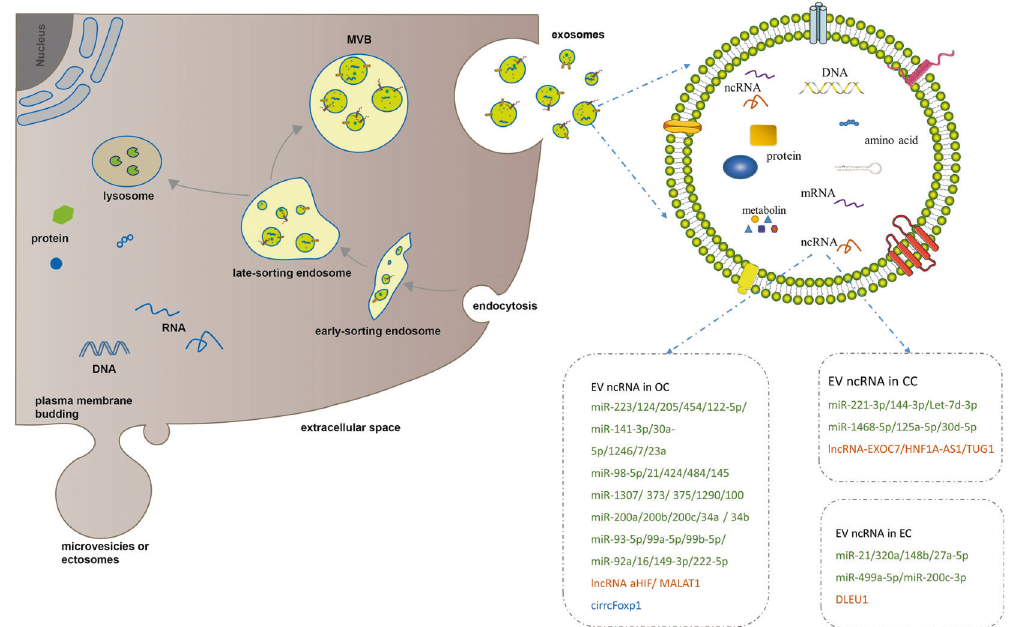
Fig. 1 Biogenesis and contents of extracellular vesicles. Microvesicles (MVs) or ectosomes are released by direct budding from the plasma membrane. Exosomes are formed by inward invagination of the endosomal limiting membrane, and released after late-sorting endosomes (LSEs) fusion with cell membrane. Exosome contains proteins, DNAs, mRNAs, ncRNAs (miRNAs, long noncoding RNAs and circRNAs) and metabolites. Previously reported EV ncRNAs in CC, OC and EC were listed in the boxes. miRNAs, long noncoding RNAs and circRNAs were respectively labeled in green, orange and